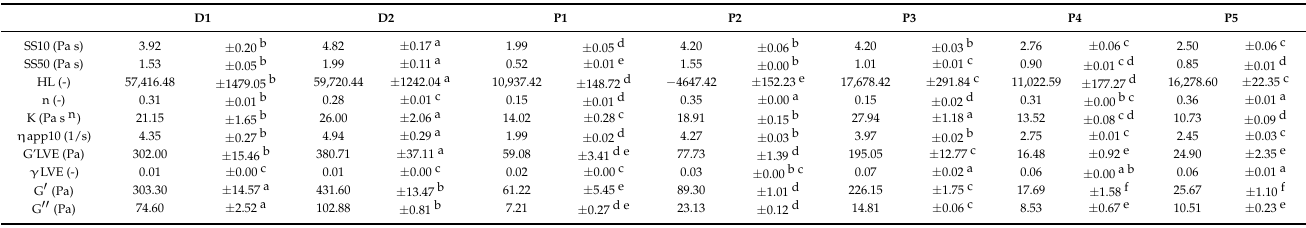
Table 5. The mean value of the rheological parameters of all the samples. Superscript letters indicate statistical differences in the same row ( p <